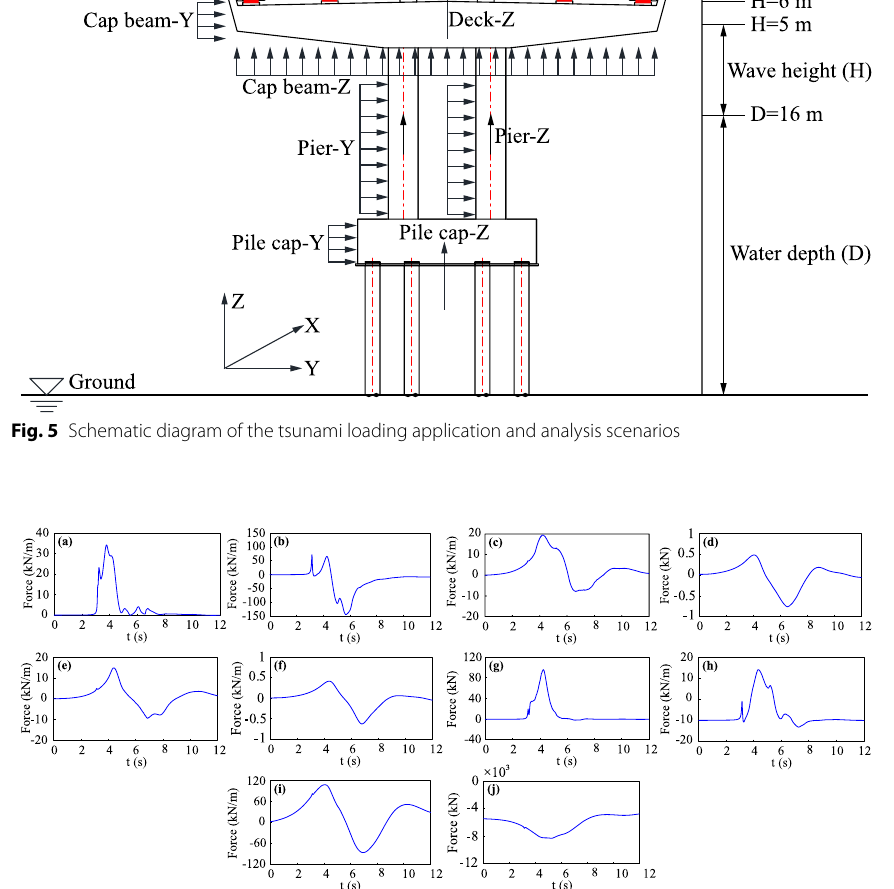
16 m and H 7 m (“-Y” and “-Z” = =